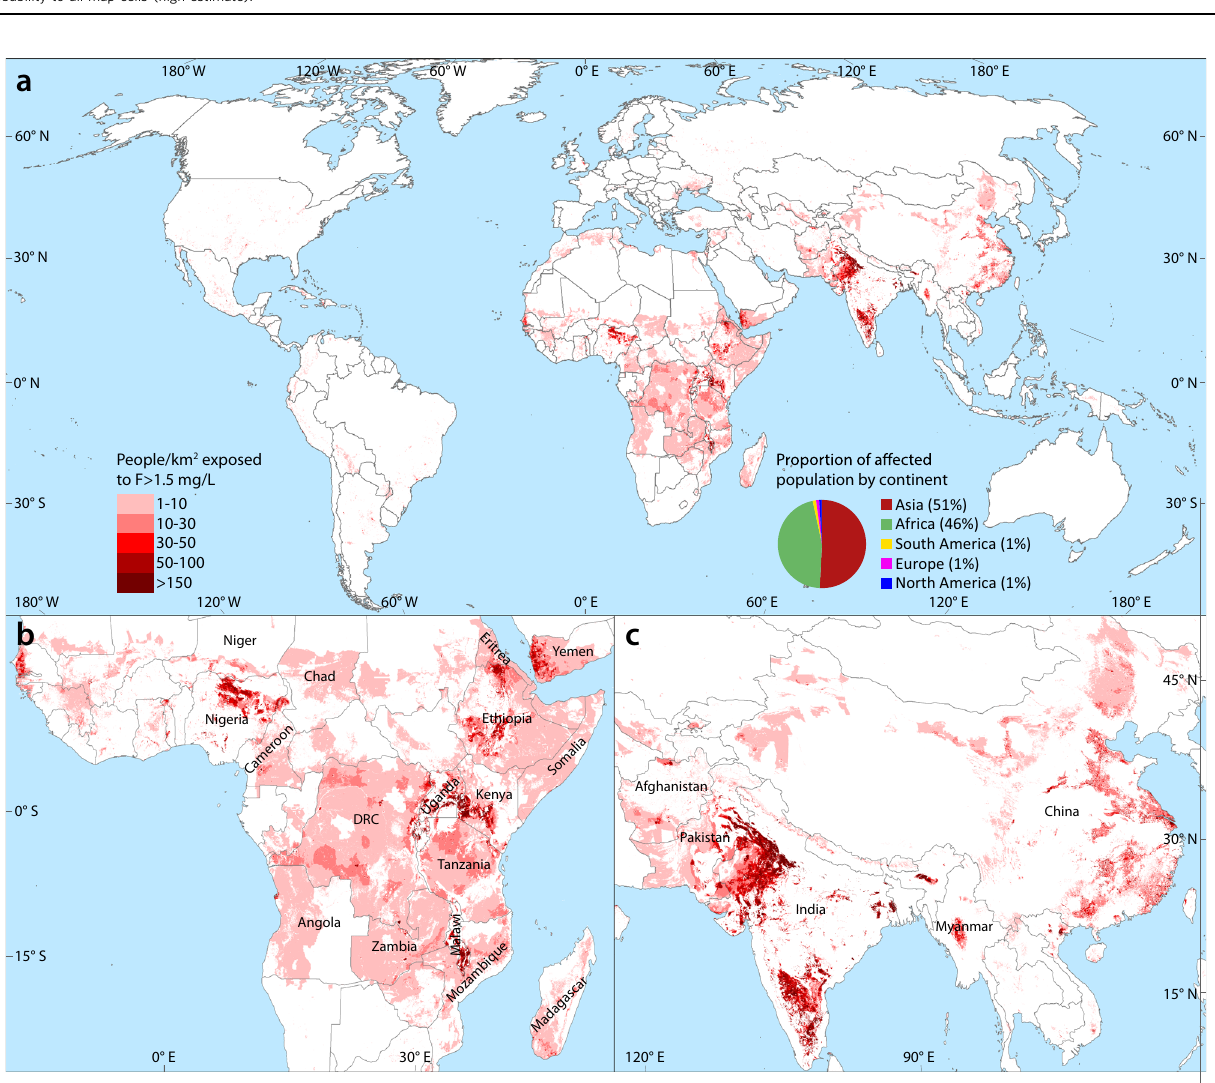
Fig. 4 Estimated population potentially exposed to fl uoride concentrations in drinking water greater than 1.5 mg/L. a Global map and break-down by continent. Detailed views of b sub-Saharan Africa and southern Arabian peninsula and c south and east Asia with the most strongly affected countries indicated. The population was calculated with the hybrid approach (see text) for areas with a greater than 25% probability of incurring high fl uoride in groundwater (Fig. 1) by multiplying the total population by the hazard percentage and the proportion of domestic water usage coming from untreated groundwater 51